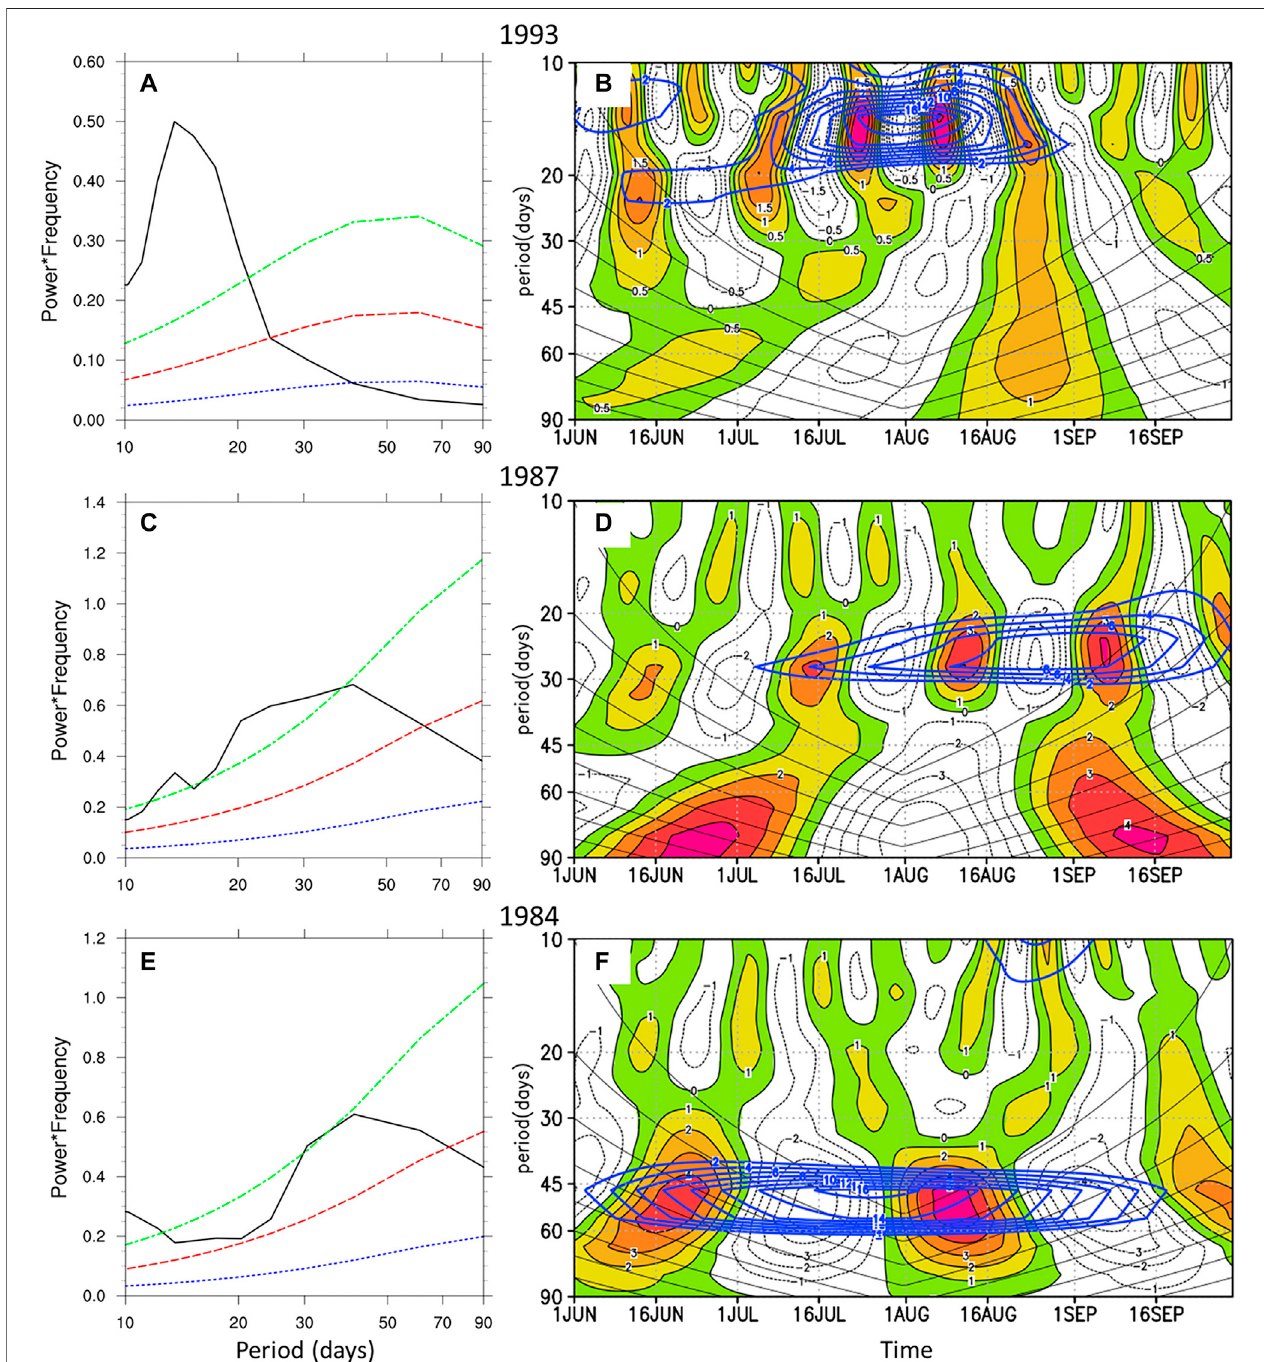
FIGURE 2 | Power spectrum of the EAP index in 1993 (A), 1987 (C) and 1984 (E) with red, blue and green line representing respectively the 95% con fi dence level, maximum and minimum Markov con fi dence levels, and real part of wavelet (B, D and F) with blue contours encircling the power spectrum passing the 95% con fi dence